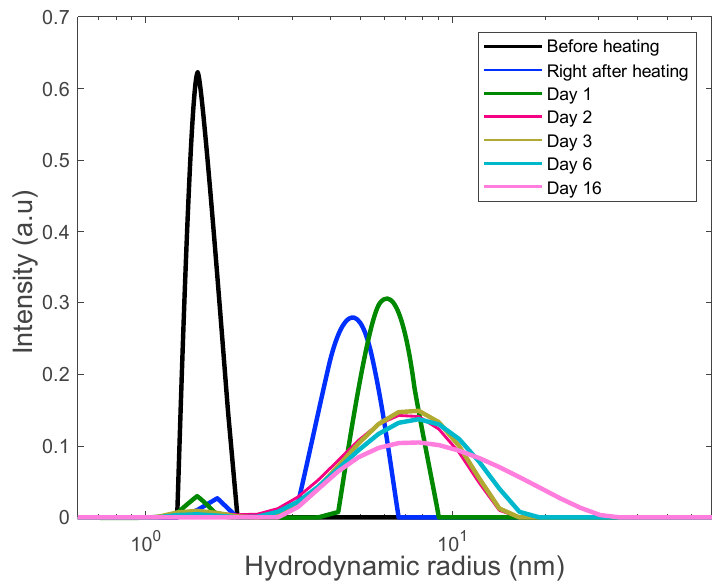
Figure 5. Long-term monitoring of the 18 mg/mL lysozyme solution via DLS. Solution was rapidly heated to the unfolding temperature of 80 °C and held there for 30 min at this temperature to trigger aggregation.